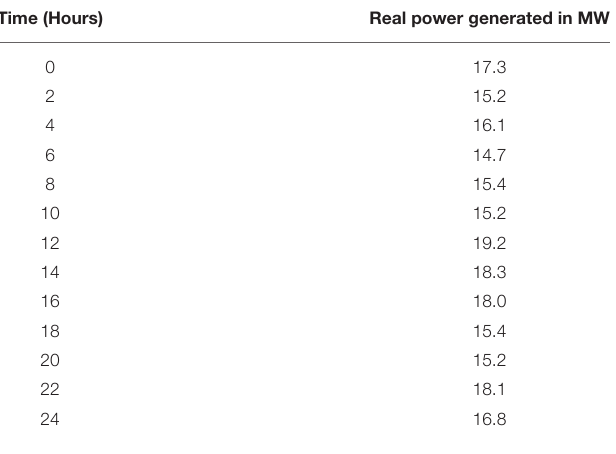
TABLE 2 | Real power output for 24